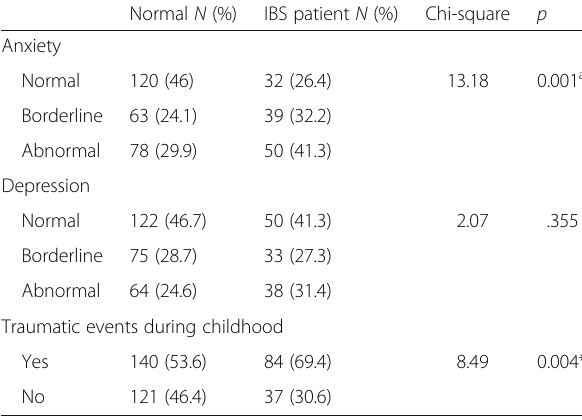
Table 5 Comparison between IBS and normal students as regards depression and anxiety scores Normal N (%) IBS patient N (%) Chi-square